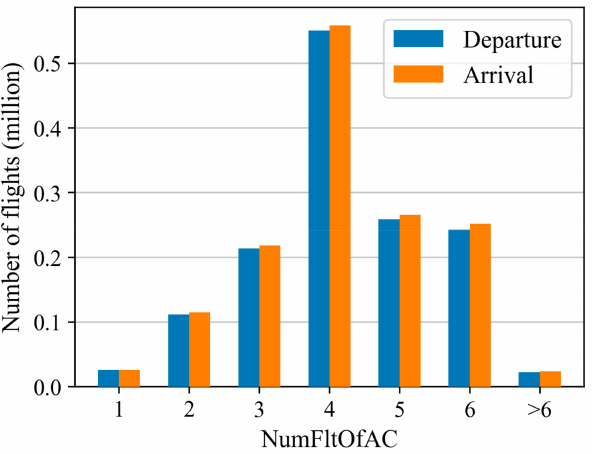
Figure 4. Distribution of the number of legs flown by aircraft in